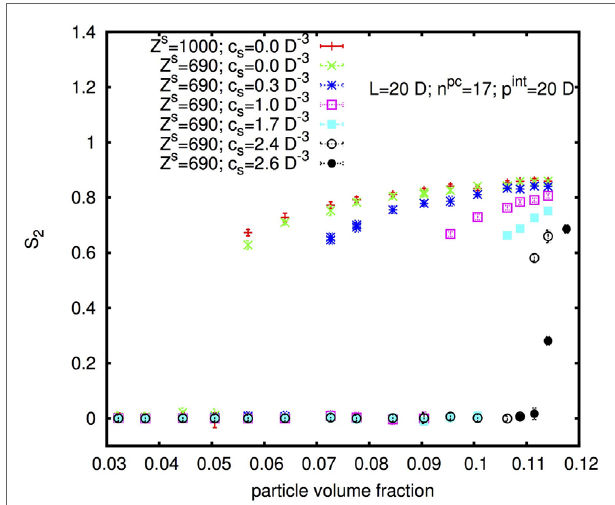
FigUre 10 | isotropic-nematic transition as a function of rod physical volume fraction, for rods with diameter D = 10 nm, length L = 20 D , and internal pitch p int = 20 D for different surface charges and different added salt concentrations c s